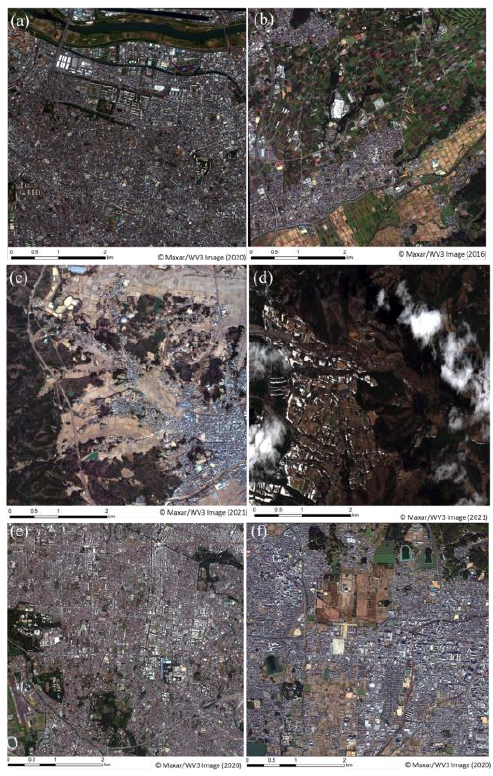
Figure 5 . WV3 images used for EXP1 and 2 (a) Itabashi (b) Mashiki (c) Joban (d) Nihonmatsu (e) Mitaka (f) Nara.